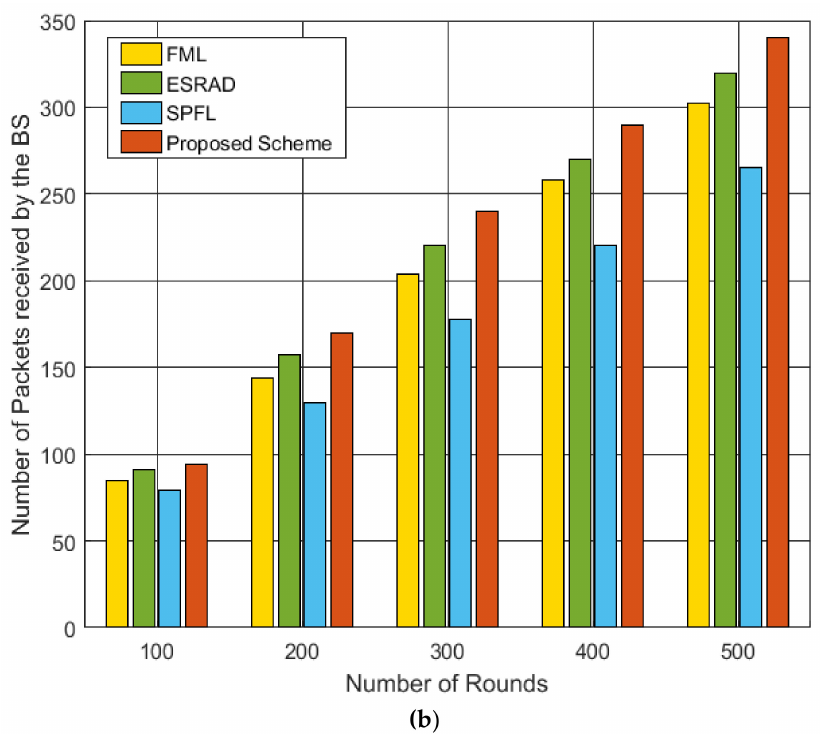
Figure 9. Performance comparison of routing schemes in terms of network throughput: ( a ) percent packet loss with respect to number of rounds; ( b ) number of packets sent to BS with respect to number of